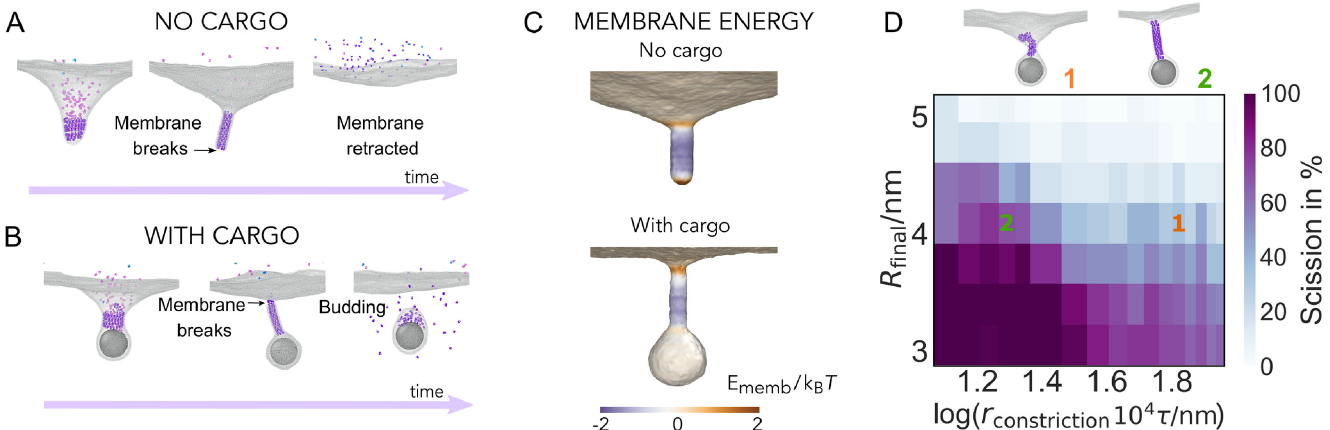
Fig 3. Membrane scission. The filament goes through a series of composition and geometry changes, from the Flat Spiral to the Wide Helix, and then to a constricting Tight Helix. A: In the absence of cargo, the membrane breaks at the bottom tip of the neck and retracts after the Tight Helix is disassembled. B: In the presence of the cargo, the membrane breaks at the top rim of the neck, which leads to membrane scission after the Tight Helix is disassembled. C: The local potential energy of the membrane (energy per bead) computed on representative snapshots before membrane breakage without (top) and in (bottom) the presence of the generic cargo. This energy is the sum of the membrane beads pair interaction, associated with bending and stretching, and the filament-membrane and cargo-membrane adhesion energies, relative to the flat membrane, and binned along the neck of the tube with bin width σ and averaged over 10 snapshots. D: Scission efficiency as a function of the final target radius of the Tight Helix, R final , and the rate of the Tight Helix constriction, r constriction . For fast constriction, the filament partially detaches from the membrane (snapshot 1 ), while for slow constriction, the filament remains attached (snapshot 2 ). Each point is an average over five independent measurements.